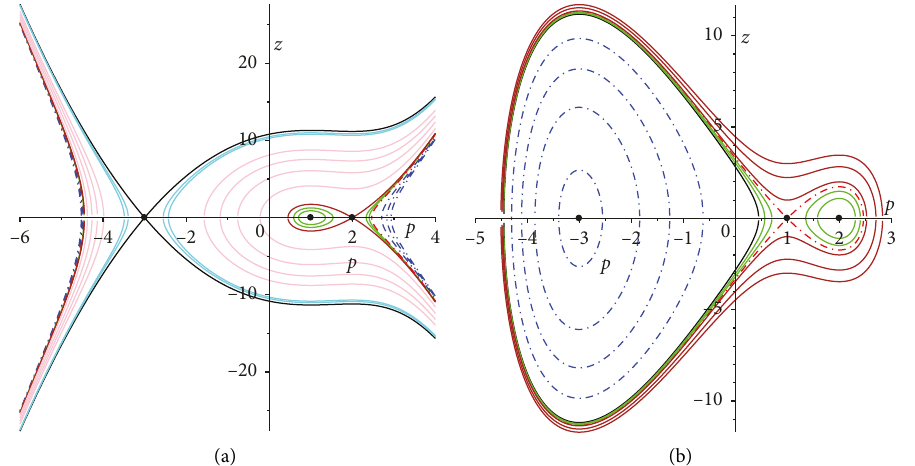
Figure 4: Phase portrait for the Hamilton system (43) for